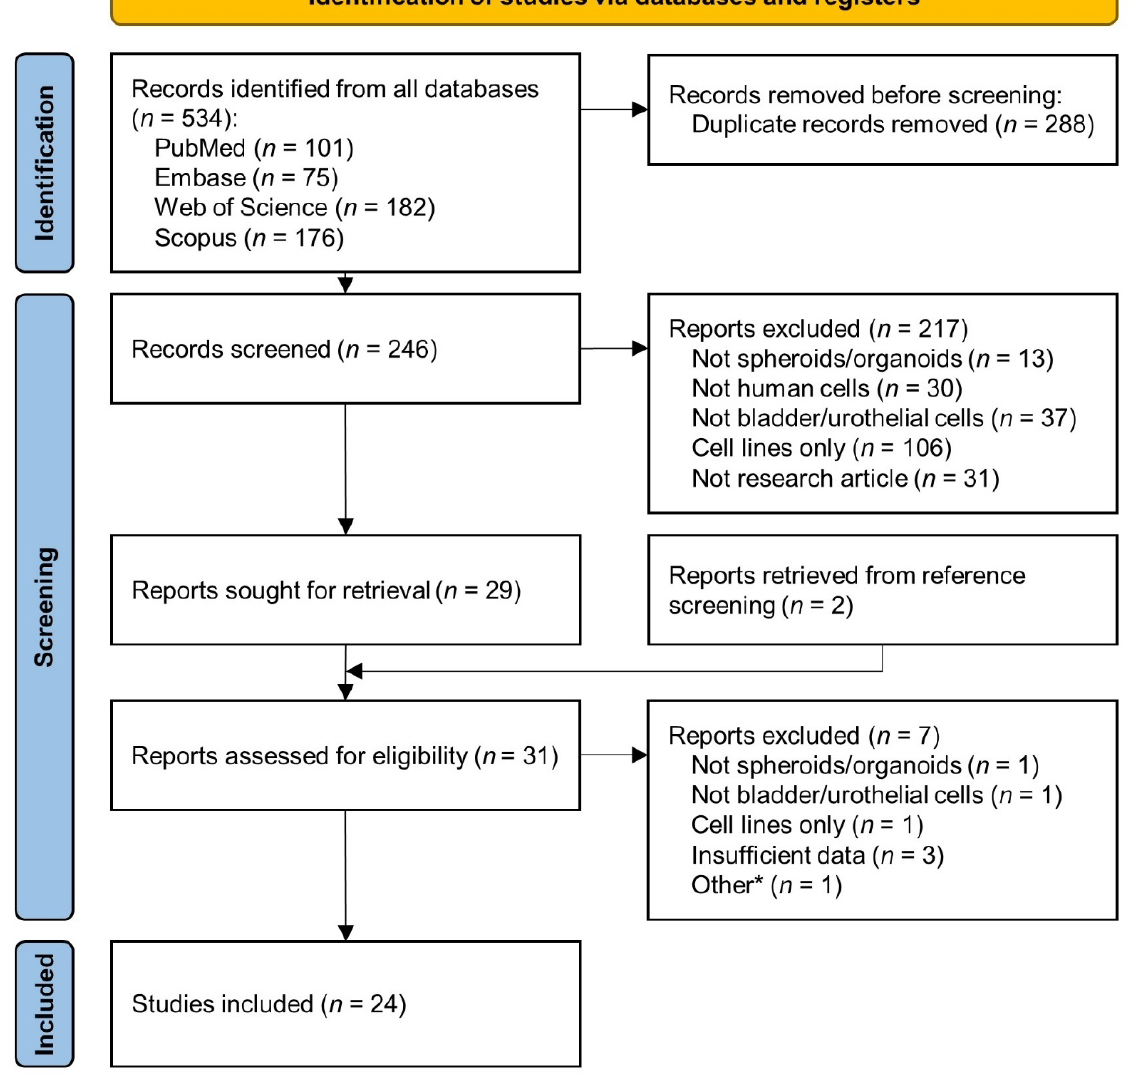
Figure 1. PRISMA flow diagram showing the study selection process. * Other indicates a report of network-based machine learning applied to published data generated in one of the studies included.